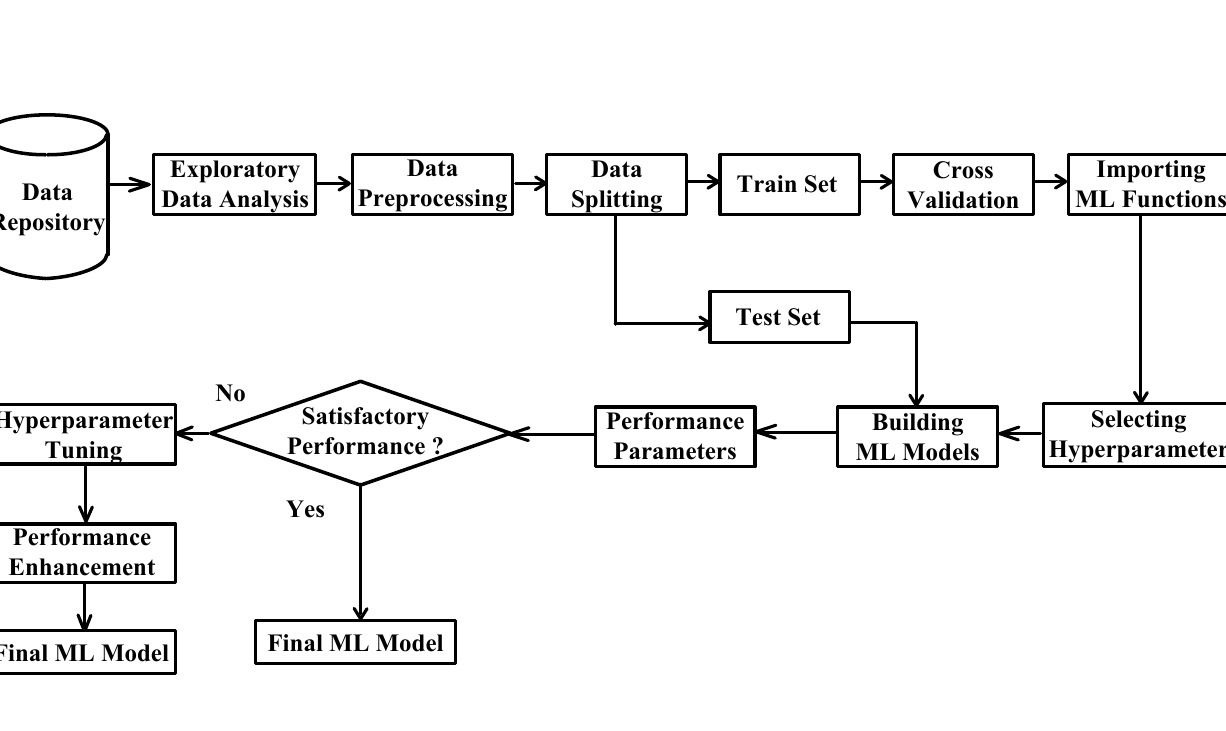
Figure 2. Overall Workflow